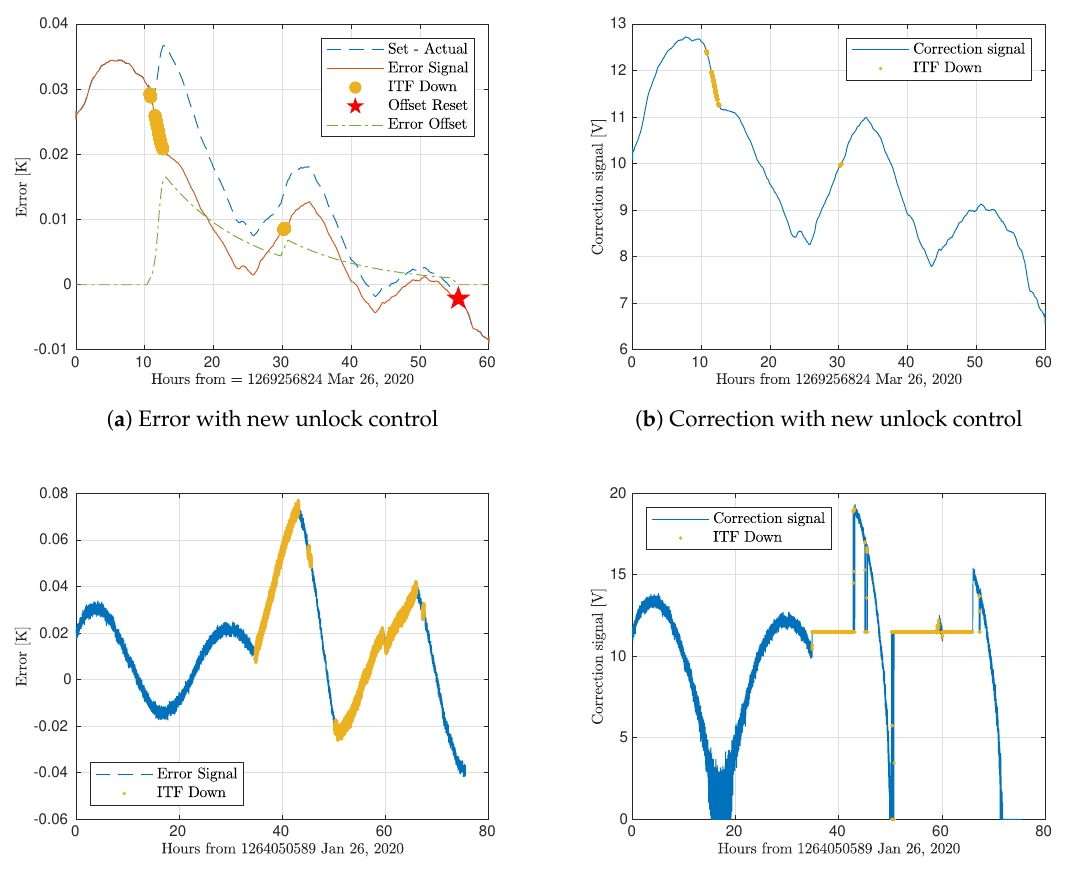
Figure 11. Comparison of etalon control performance during an unlock with and without the new unlock control. With the unlock condition, ( a ) shows an offset, calculated from the laser plant, is subtracted from the set temperature to match mirror cooling so that the error is consistently driven to zero. Additionally, ( b ) shows that the correction signal remains smooth during the unlock and relock periods. Without the unlock condition, ( c ) shows that the error increases during unlock due to cooling in the laser absence. When the ITF relocks, the increased error is seen as a step input which causes an overshoot in the correction signal shown in ( d ), particularly as the mirror heats due to the